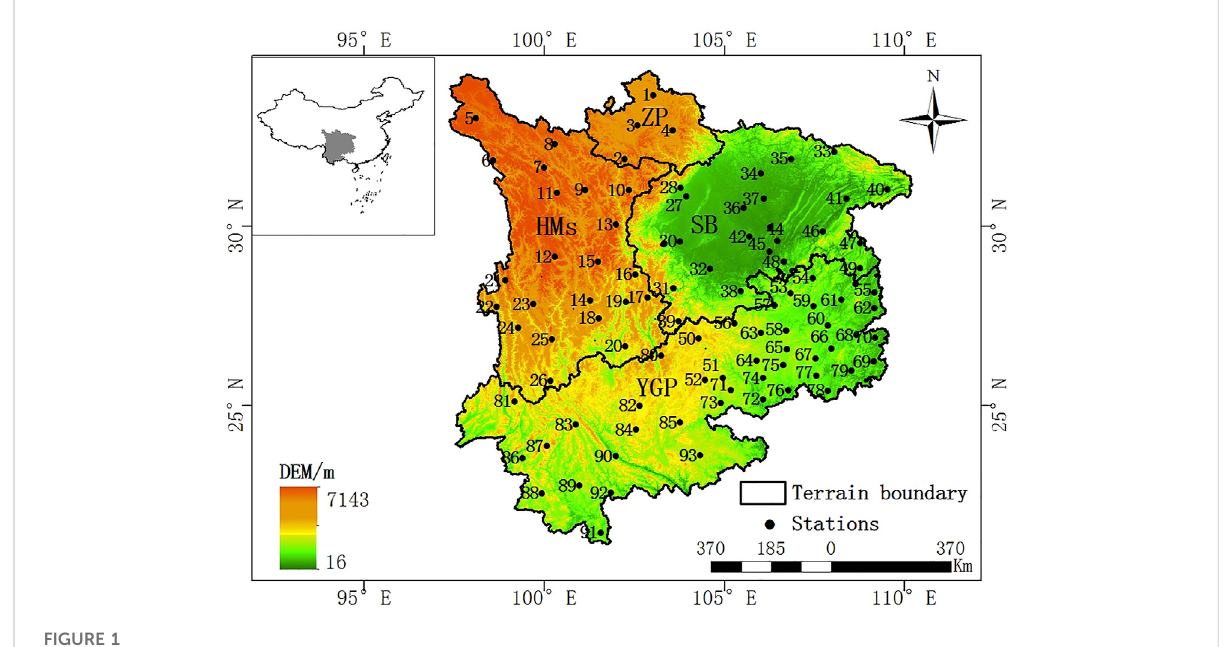
FIGURE 1 Spatial distribution of weather stations and topographical division in Southwest